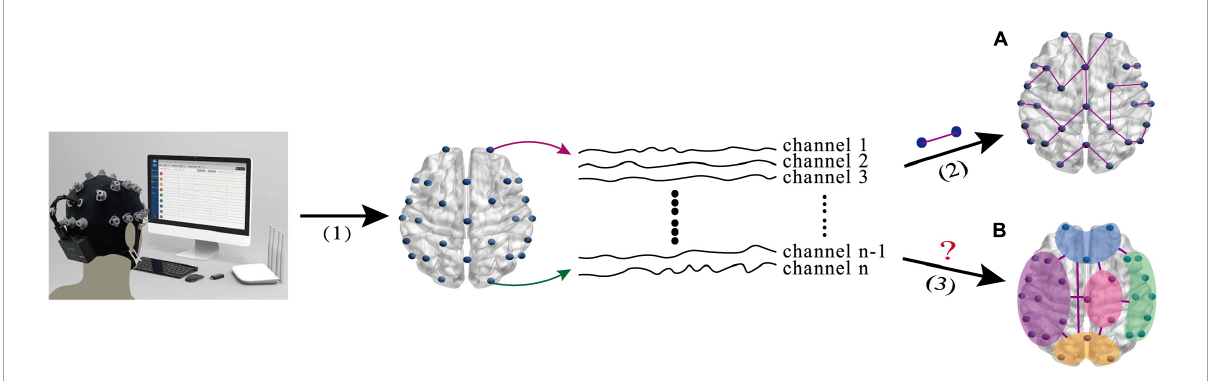
FIGURE1 The intuitive explanation of brain network research based on EEG signals. (A) The low-order FC (LO-FC) between two channels. (B) High-order FC (HO-FC) among channels. (1) EEG signal acquisition(1) EEG signal acquisition, (2) calculation of correlation between two channels, and (3) calculation of correlation among multiple channels.